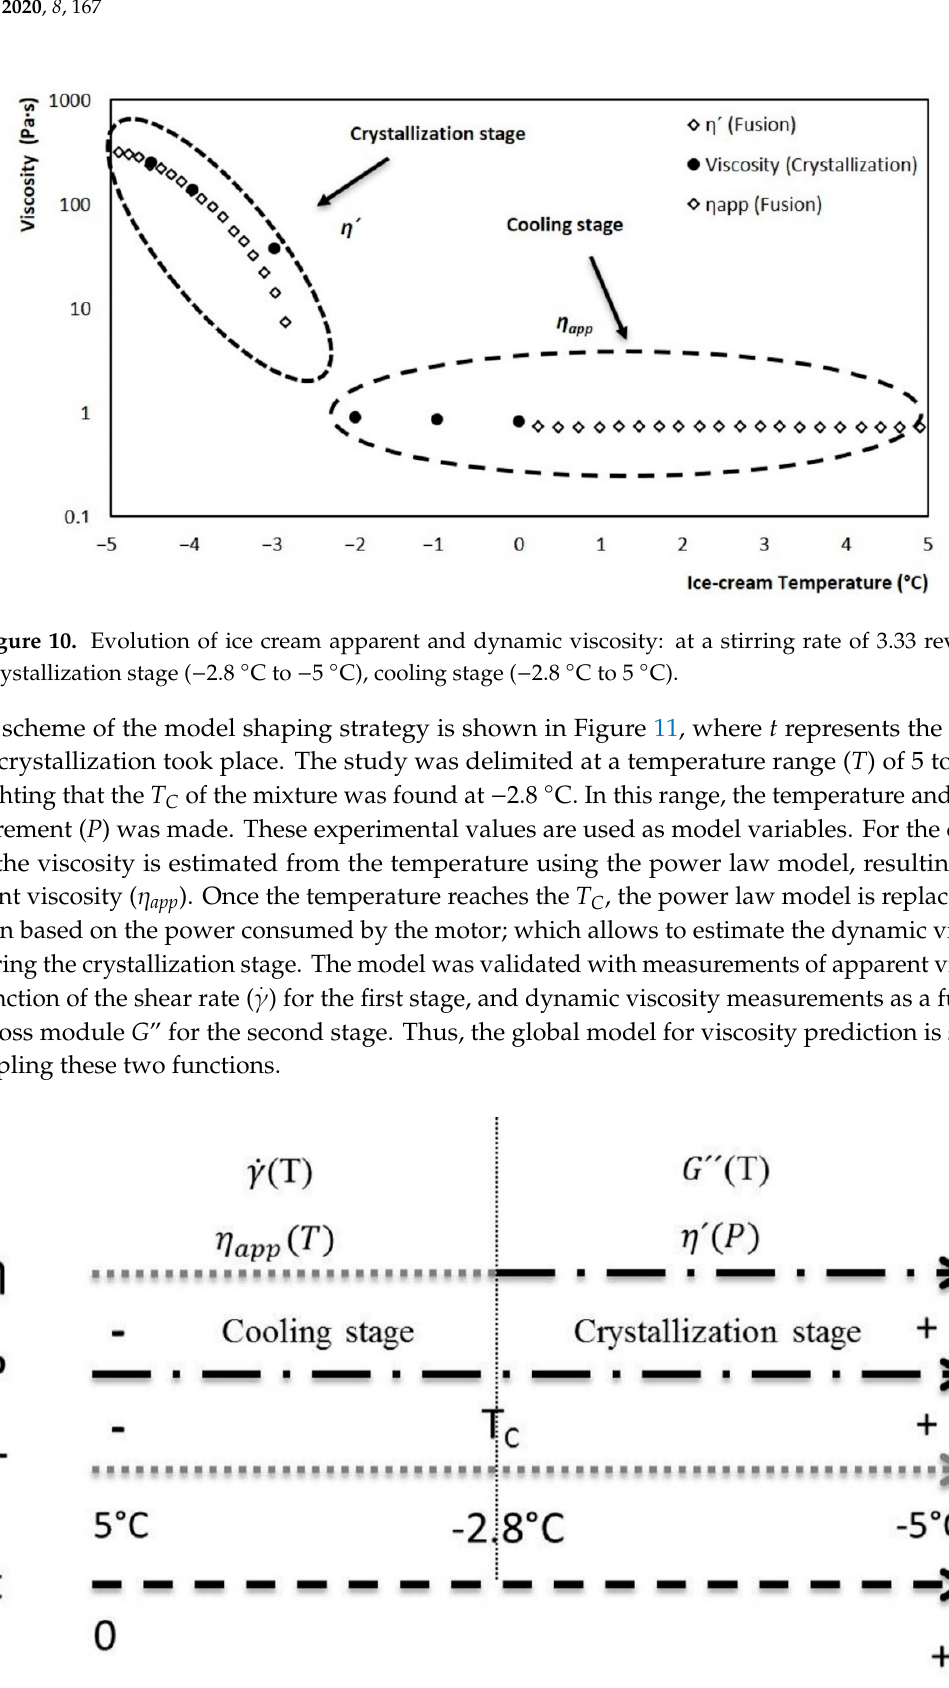
Figure 11. Representation of the model’s two stages of action. T C is the mixture’s crystallization temperature, P is power consumed by the stirring motor, η is the viscosity ( η app is apparent viscosity, η ’ is dynamic viscosity), t is time, 𝛾(cid:4662) is velocity of cut and G ” is the loss module.